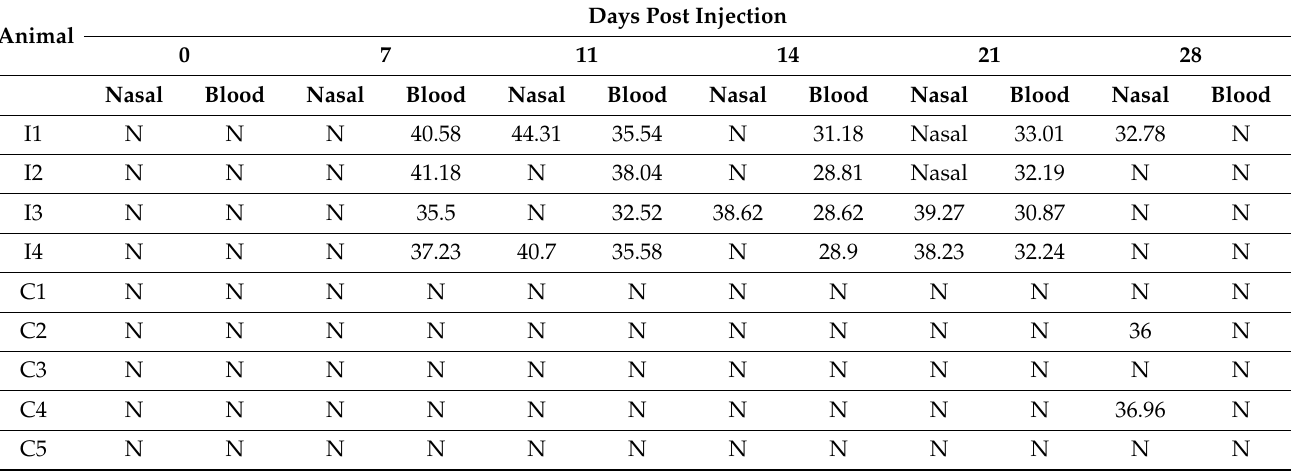
Table 1. Detection of virus genome by PCR in blood and nasal swabs of animals IM inoculated with ASFV-G- ∆ I177L (I1–I4) and naïve contact animals (C1–C5). Results are expressed as negative (N) or Ct